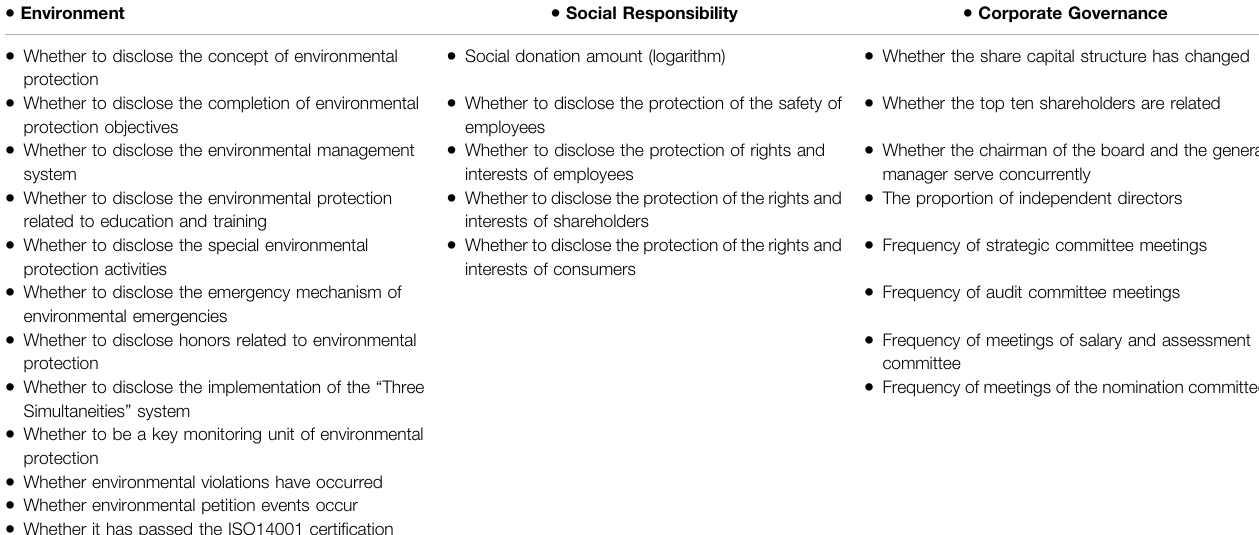
TABLE 1 | First principal component of each component.